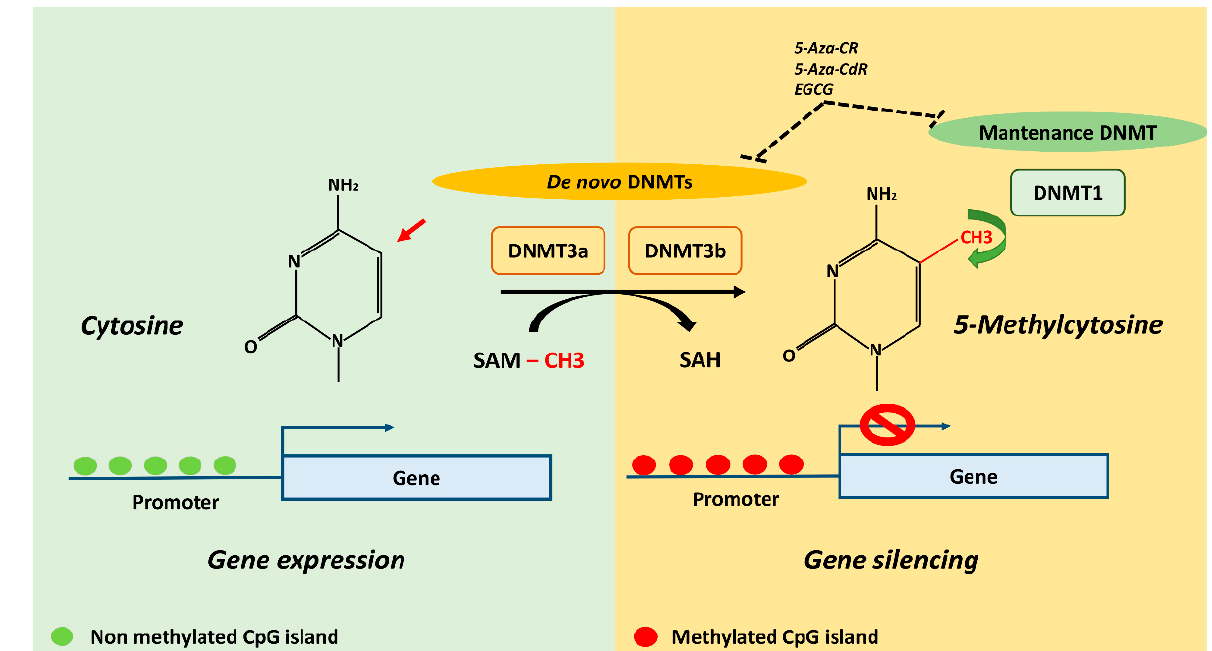
Figure 1. DNA methylation mechanism and potential DNMT inhibitors (DNMTi). The transfer of methyl (CH3) group to the C5 position of the cytosine to create 5-methylcytosine (5mC) is actuated by DNMTs which catalyze the addition by sequestering CH3 group from SAM methyl donor. DNMT3a and DNMT3b establish initial methylation patterns and DNMT1 maintain the already established methylation patterns. The CpG islands represents the richest regions of GC sites which are usually located in gene promoters and 5 ′ regulatory regions, and its methylation is generally associated with gene silencing. Demethylating agents 5-Aza-CR, 5-Aza-CdR and EGCG are known to inhibit DNMT3a, DNMT3b and DNMT1 activity. DNMTs, DNA methyltransferases; SAM, S-adenosylmethionine; SAH, S-adenosylhomocysteine; 5-Aza-CR, 5-Azacytidine; 5-Aza-CdR, 5-aza-2 ′ -deoxycitidine; EGCG, epigallocatechin-3-gallate.